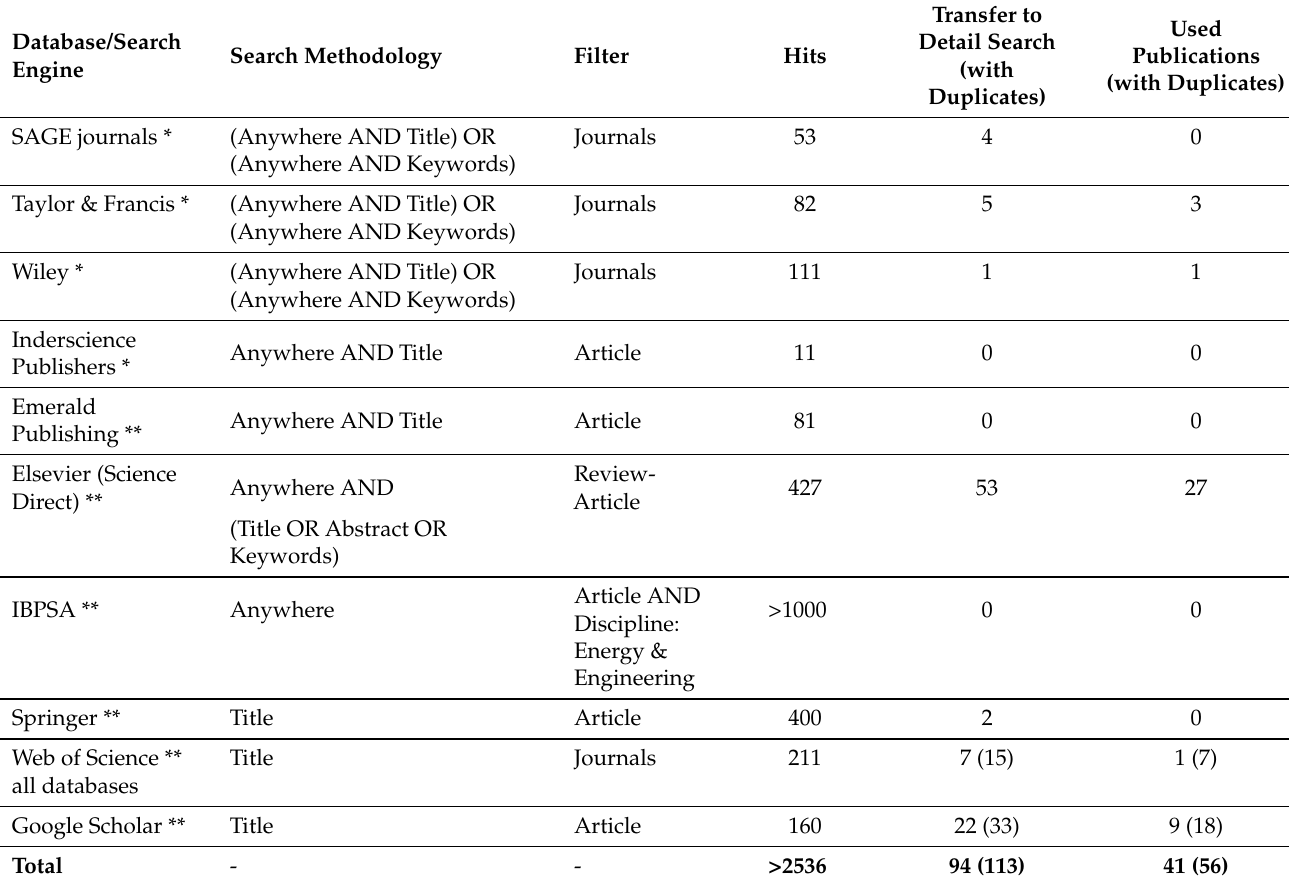
Table 2. List of main research databases used to perform the literature search (* Complete search string, ** Substrings); The data in the columns ‘Transfer to detailed search’ and ‘Used publications’ are without duplicates and with duplicates, the latter value is listed in